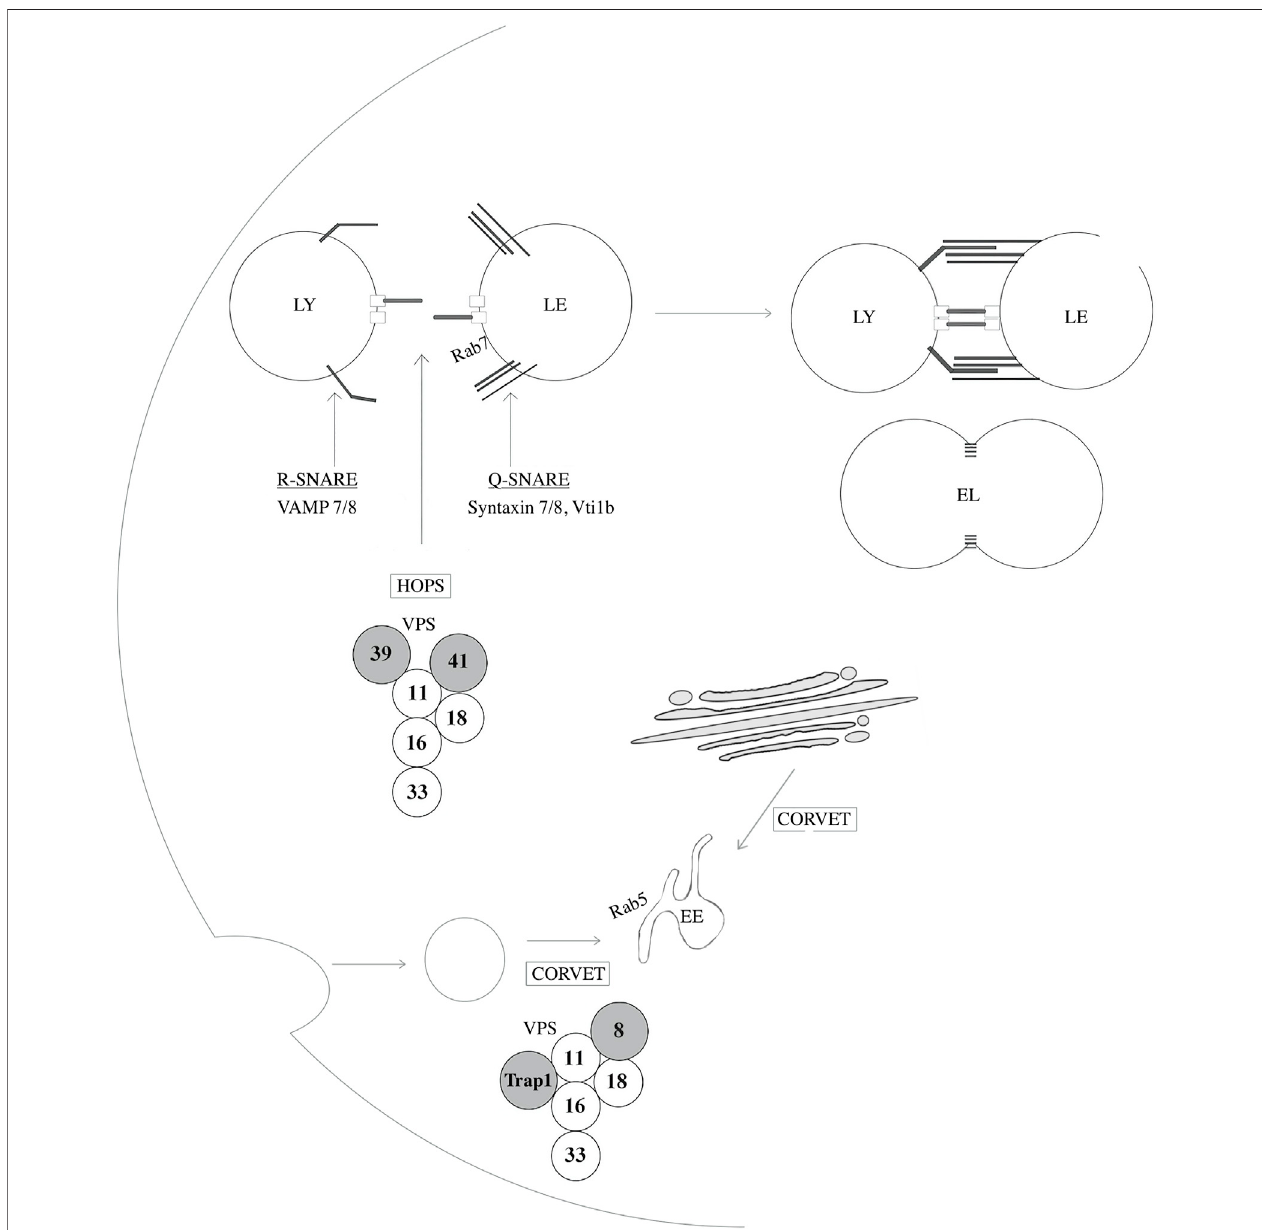
FIGURE 4 | Proteins implicated in lysosome-endosome fusion events. SNAp REceptor (SNARE) proteins regulate fusion events between lysosomes and other organelles such as late-endosomes, autophagosomes, and amphisomes. VAMP7 and VAMP8 are R-SNAREs, a type of SNARE proteins that provides an arginine (R) residueintheassemblyoftheSNAREcomplexandarelocatedatthelysosomalmembrane.Syntaxin7,Syntaxin8andVTI1BareQ-SNARES,providingaglutamine(Q) residue in the assembly of the SNARE complex, and localize to late endosomes (LE). The homotypic fusion and vacuole protein sorting (HOPS) tethering complex assures heterotypic fusion between endosomes and lysosomes (LY) by fi rst recognizing and interacting with Rab7. Similarly, the class C core vacuole/endosome tethering(CORVET)mediateshomotypicfusionofRab5-positiveearlyendosomes(EE).Thesetwotetheringcomplexessharecoremembers,VPS11,16,18,and33A/B while HOPS and CORVET uniquely contains VPS39 and VPS41 and VPS8 and TRAP-1, respectively. EL: Endolysosome.